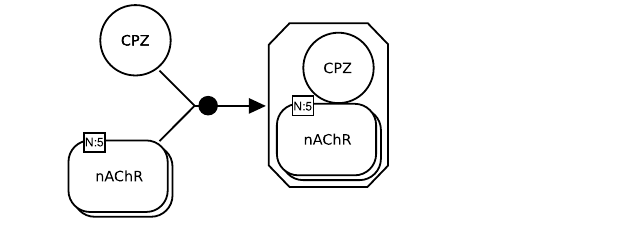
Figure 2.36: The association of a pentameric macromolecule with a simple chemical in an unnamed complex.